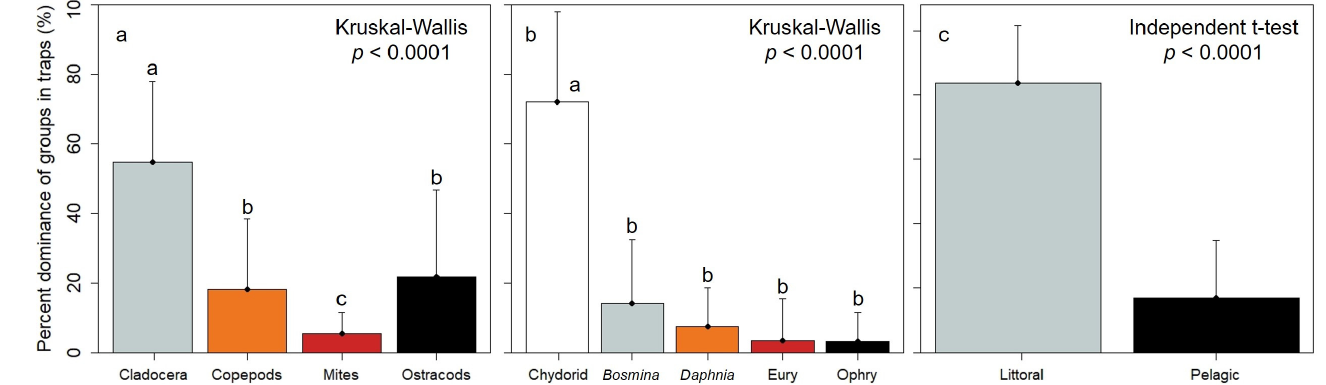
Figure 3. Percent density dominance in bladderwort traps of ( a ) major, broad taxonomic groups, ( b ) different taxa within Cladocera, and ( c ) littoral versus pelagic taxa. In panel ( b ) Eury = Eurycercus and Ophry = Ophryoxus . Letters above bars in ( a , b ) denote statistical differences; n = 27 for each analysis.